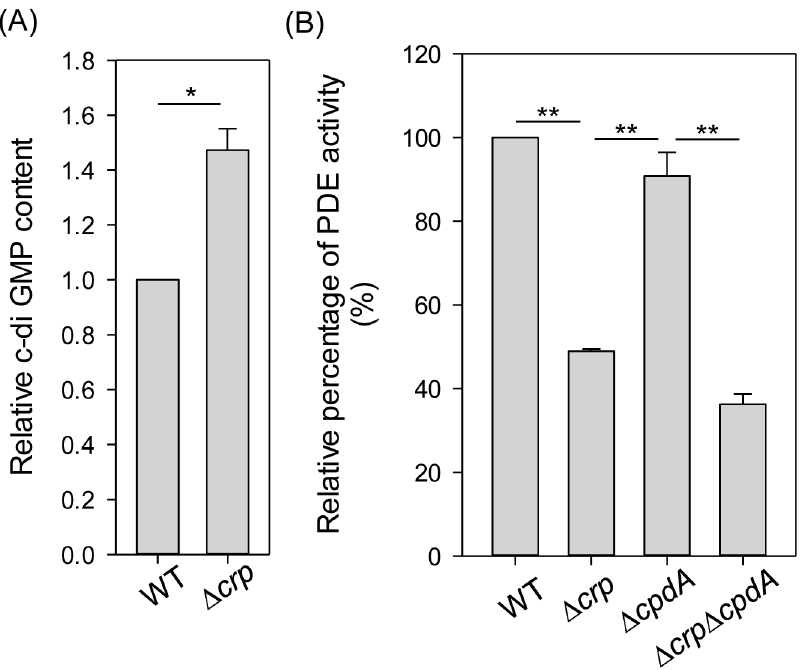
Fig 6. CRP affects the intracellular c-di-GMP amount and the PDE activity. (A) Relative c-di-GMP content of WT and Δ crp strains in LB medium was quantified by ELISA according to the manual (Wuhan EIAab Science). (B) The PDE activity of crude extracts of WT and Δ crp strains was determined by using bis- p NPP as substrate and measuring the absorbance at OD410. Relative percentage of PDE activity was calculated by the OD410 of crude extracts is relative to the OD410 of WT strain. The results are representative of three independent experiments. Error bars indicate standard